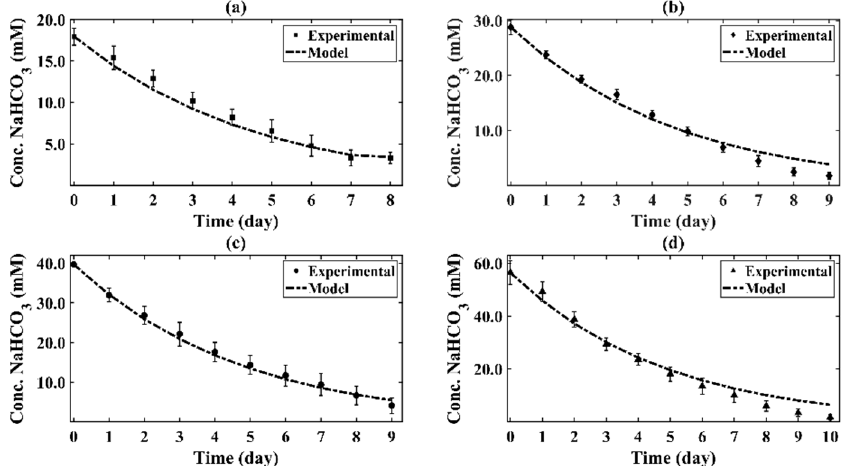
Figure 6. NaHCO 3 concentration changes with culture time for nominal initial concentrations of ( a ) 18, ( b ) 28 ( c ) 40, ( d ) and 60 mM. Note: reported results include at least 3 repeats.